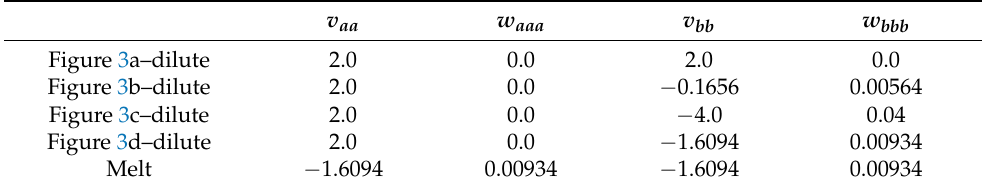
Table 1. Virial coefficients used for simulations of diblock copolymer solution self-assembly. Virial coefficients for A and B blocks under the melt condition and in a dilute solution used to predict phase diagrams in Figure 3a–d, which corresponds to a good, theta, slightly poor, and poor solvents to the B block, are compiled in Table. The solvent quality for A block is fixed to be good over all cases; thus, v aa and w aaa are set to be constant as 2.0 and 0.0, respectively. Melt condition virial coefficients are the same for all subfigures and for both species A and